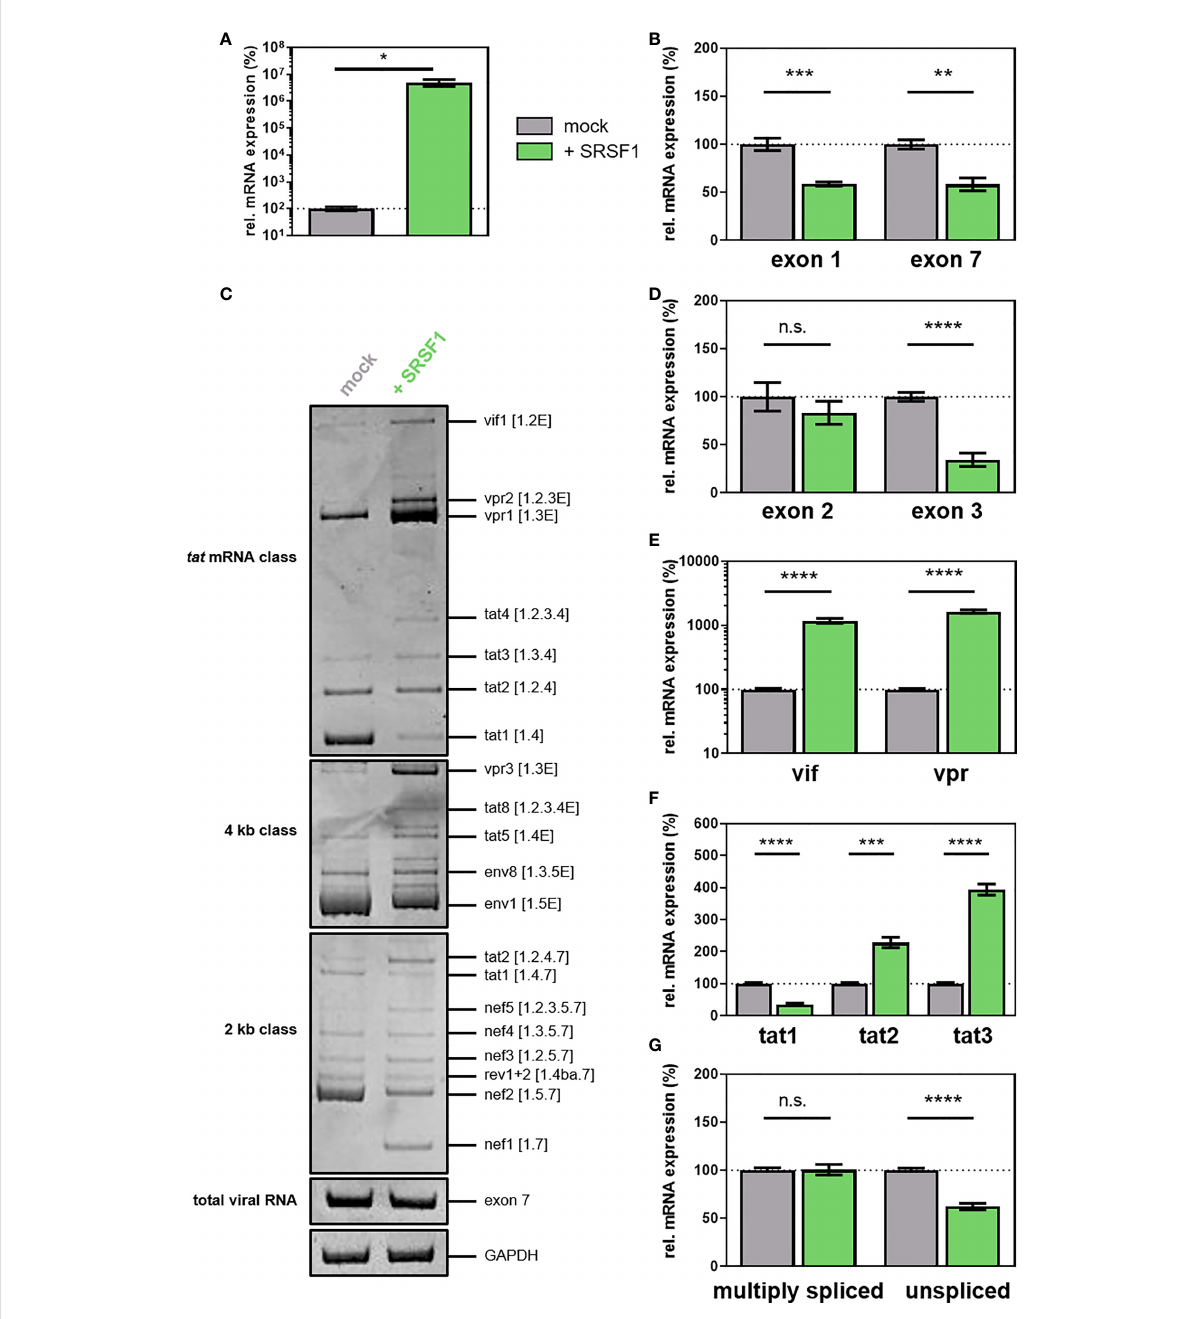
FIGURE 9 (A – G) Overexpression of SRSF1 affects HIV-1 LTR transcription and alternative splice site usage. HEK293T cells were transiently transfected with a plasmid coding for the proviral clone NL4-3 PI952 (pNL4-3 PI952) and a plasmid expressing FLAG-tagged SRSF1 (pcDNA-FLAG-SF2) or an empty vector [pcDNA3.1(+)] as mock control. Cellular RNA and cell culture supernatant were harvested 72 h post-transfection and subjected to further analysis. (A, B) RT-qPCR was performed to determine relative mRNA expression levels of (A) SRSF1 and (B) exon 1- and exon 7- containing mRNAs (total viral mRNA). GAPDH was used for normalization. (C) RT-PCR was performed using the indicated primer pairs covering the viral mRNA isoforms of the 2-kb, 4-kb, and tat mRNA class (Supplementary Tables 1, 2 and Supplementary Figure 4). HIV-1 transcript isoforms are indicated according to Purcell and Martin (36). HIV-1 exon 7-containing transcripts as well as cellular GAPDH were included as loading controls. PCR amplicons were separated on a 12% non-denaturing polyacrylamide gel. (D, G) Total RNA was subjected to RT-qPCR to measure relative mRNA expression levels of (D) exon 2- and exon 3-containing, (E) vif and vpr , (F) tat1 , tat2 , and tat3 , and (G) multiply spliced and unspliced mRNAs using the indicated primers. Relative viral splice site usage was normalized to exon 7-containing mRNAs (total viral RNA). Unpaired two-tailed t -tests were used to calculate statistical signi fi cance (* p < 0.05, ** p < 0.01, *** p < 0.001, and **** p < 0.0001). Mean ( ± SEM) of n = 4 biological replicates is depicted for (A, B) and (D – G) . For (C) , a representative gel is shown. ns is not signi fi